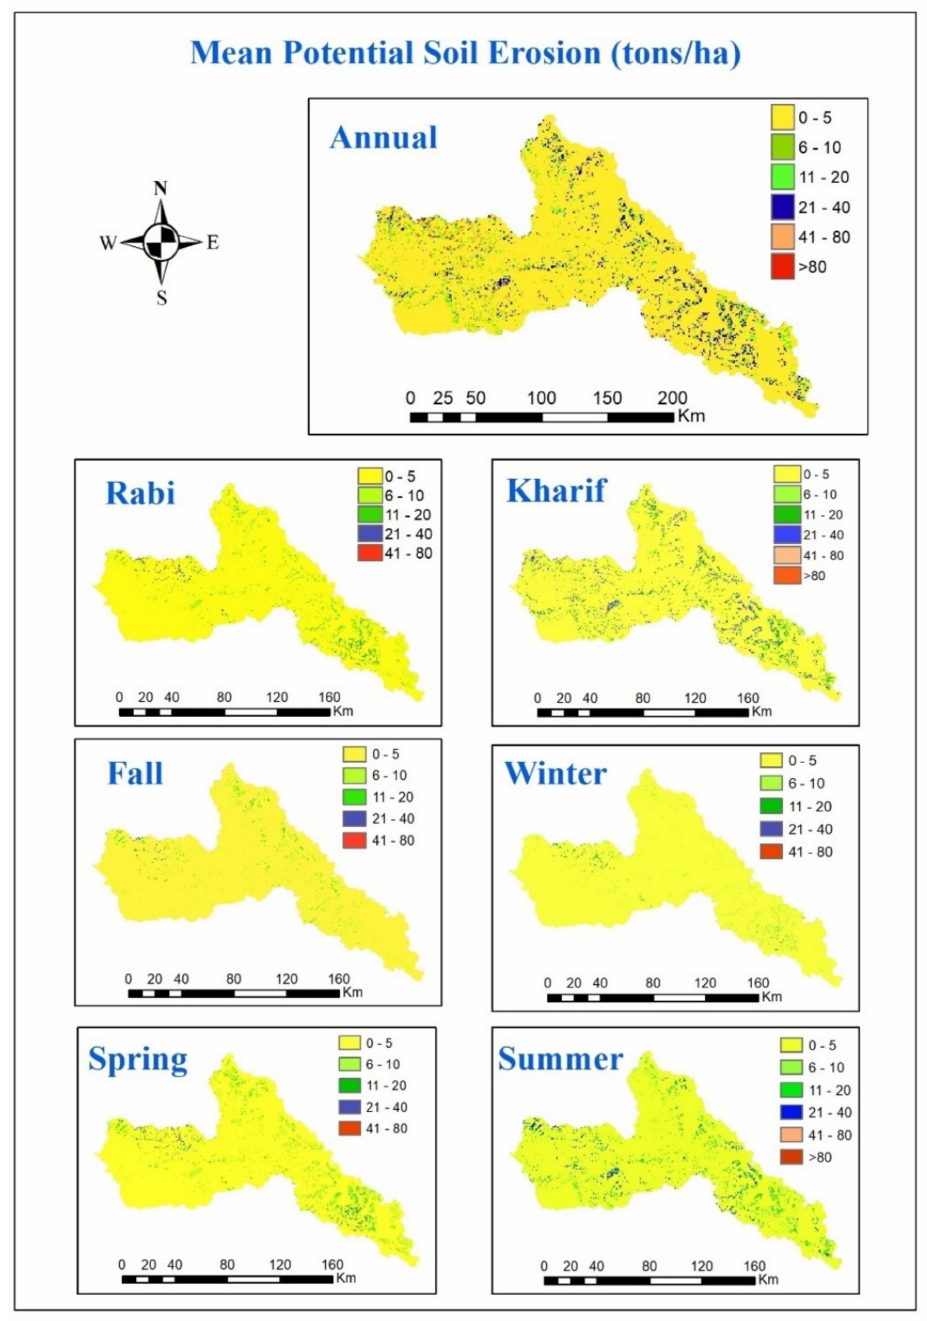
Figure 7. 30-year average potential soil erosion from the Chenab river catchment at different time-